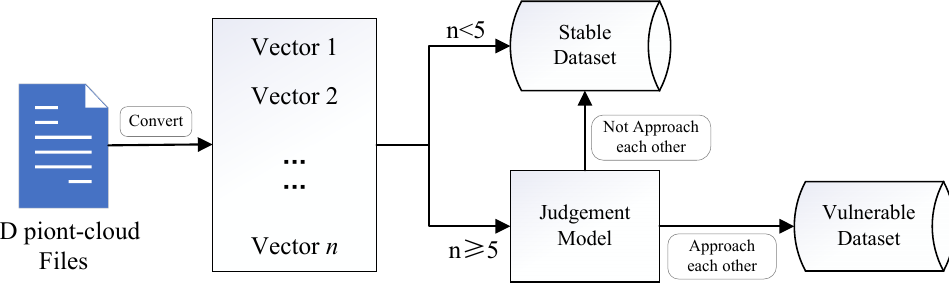
Figure 8. Structure of the data filter.